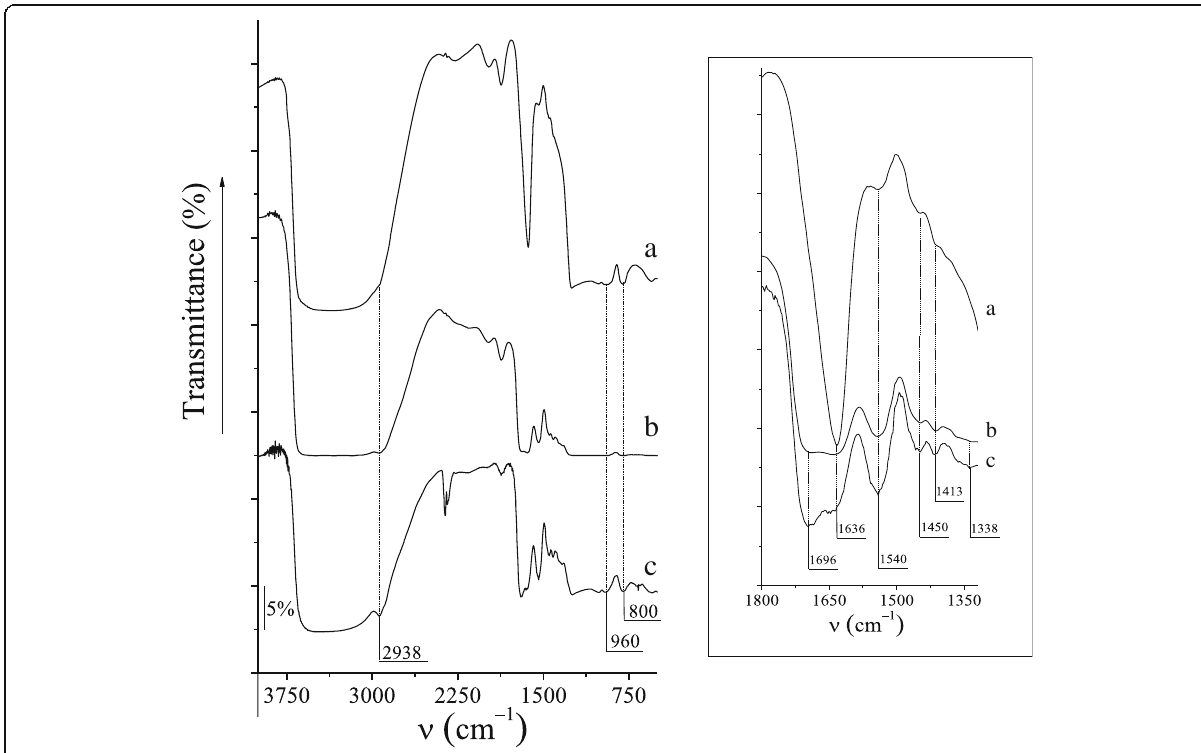
Fig. 1 IR spectra of β -CD-APTES-MCM-41 ( a ), β -CD-APTES 3 -MCM-41 ( b ), and β -CD-APTES 5 -MCM-41 ( c ) silicas